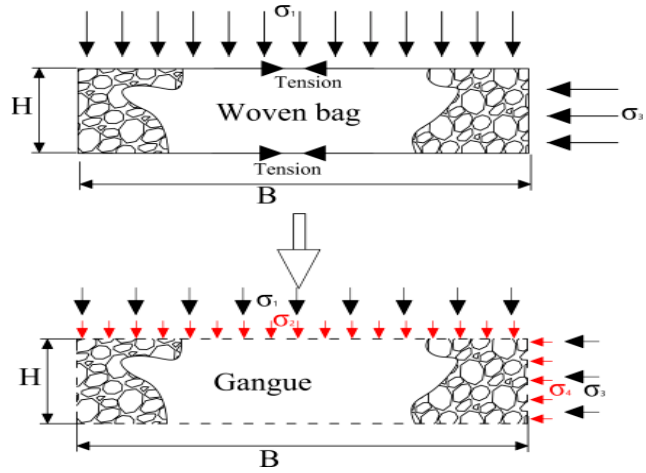
Figure 2. The mechanical model of a gangue bag failure.